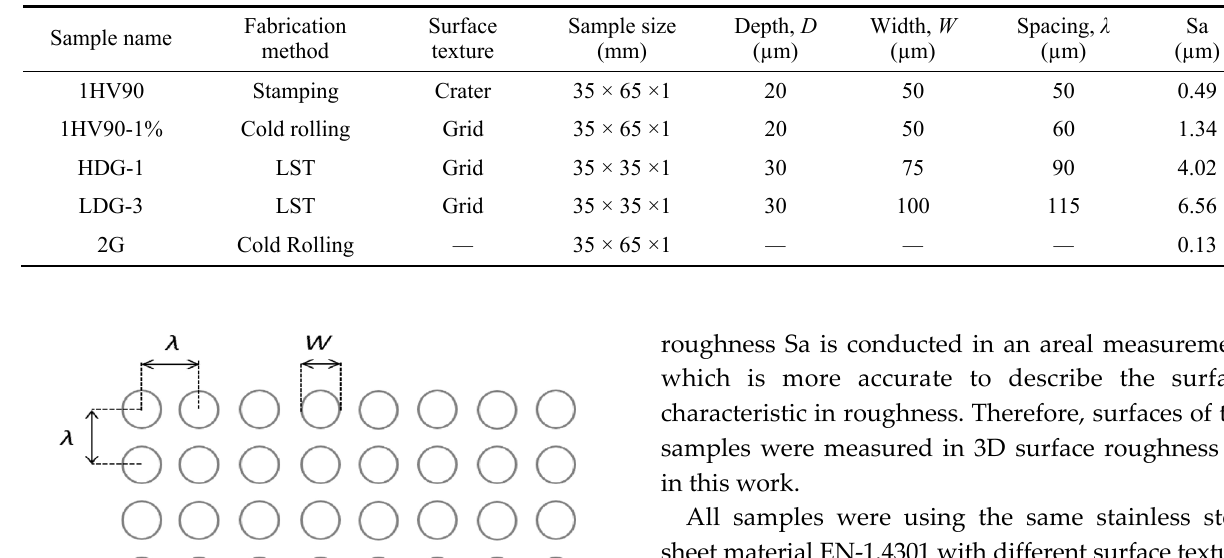
Table 1 The surface parameters of the samples with depth ( D ), spacing ( λ ), width ( W ), 3D surface roughness (Sa) were measured